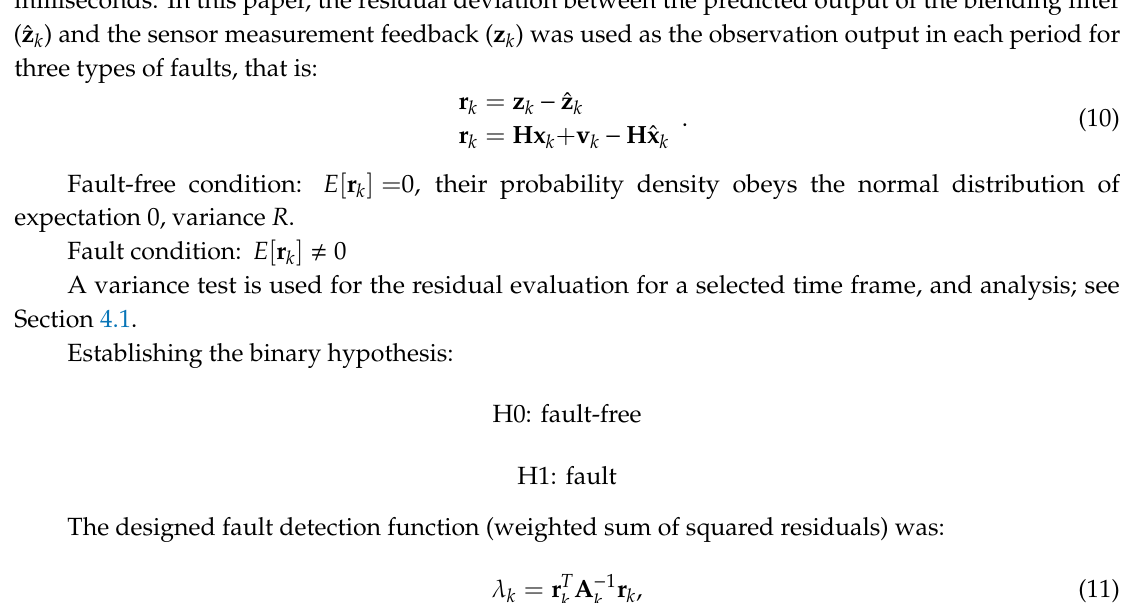
Figure 4. Blending of the physical filter and Kalman filter state estimation under the interference of approximate control signal noise.